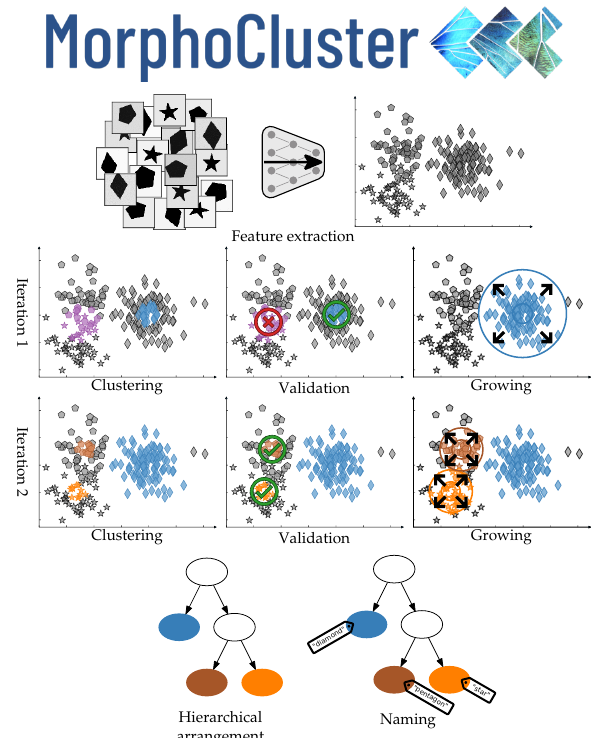
Figure 1. Overview of the MorphoCluster method. Images are projected to the feature space. Iteration 1: The blue cluster is validated and grown, while the purple one is rejected. Iteration 2: The orange and brown clusters are validated and grown. Finally, the clusters are arranged in a hierarchy and